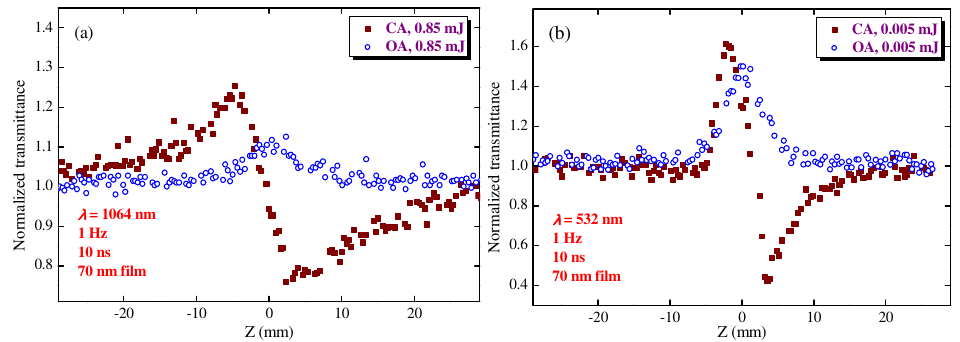
Figure 7. Z-scans of 70 nm-thick HgS QD film using 10 ns probe pulses. ( a ) 1064 nm probe pulses. ( b ) 532 nm probe pulses. The energies of probe pulses are shown on the graphs.